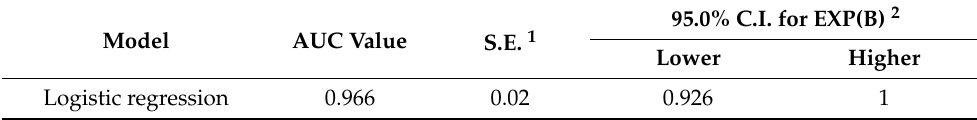
Table 5. The result of validation